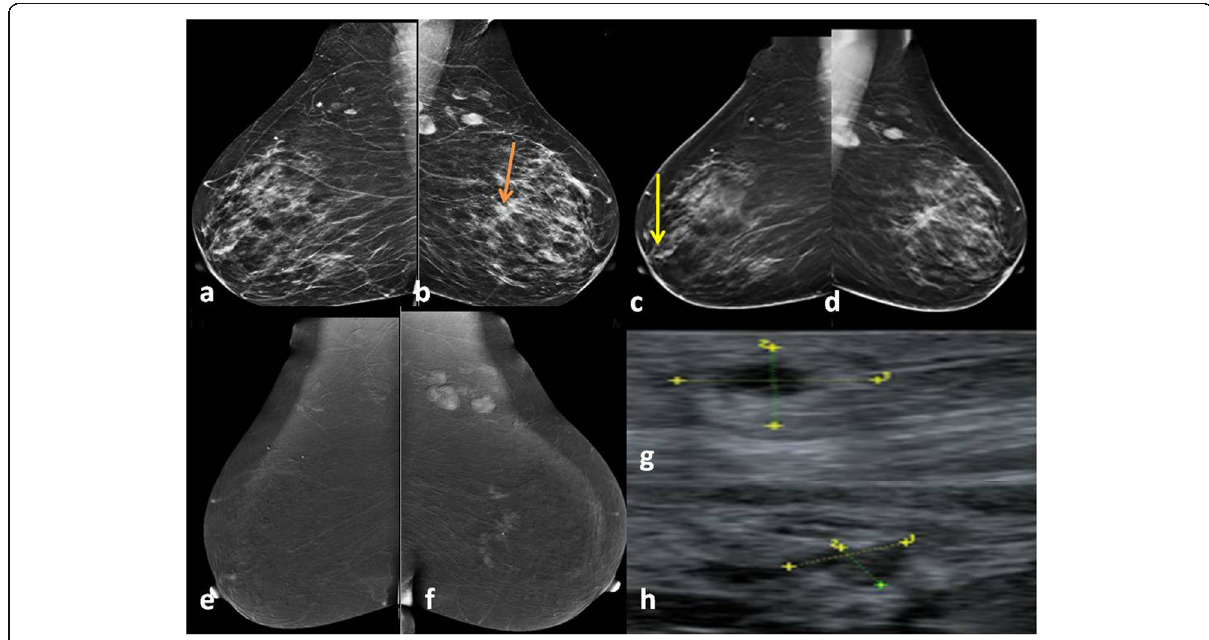
Fig. 4 A 60-year-old patient presented by a lump in the left breast. Mammography revealed focal asymmetry in the left upper inner quadrant with microcalcifications ( a , b ). DBT showed left breast spiculated mass with microcalcifications as well as right breast retroareolar nodule with microcalcifications ( c , d ). CEM showed left breast heterogeneously enhancing upper inner quadrant mass lesion with spiculated margins and surrounding multiple satellite lesions as well as right breast tiny right retroareolar homogenously enhancing mass with not circumscribed irregular margins ( e , f ). Breast ultrasound showed left breast irregular ill-defined mass in the left upper inner quadrant as well as right retroareolar small irregular ill-defined mass ( g , h ). The final diagnosis was bilateral invasive duct